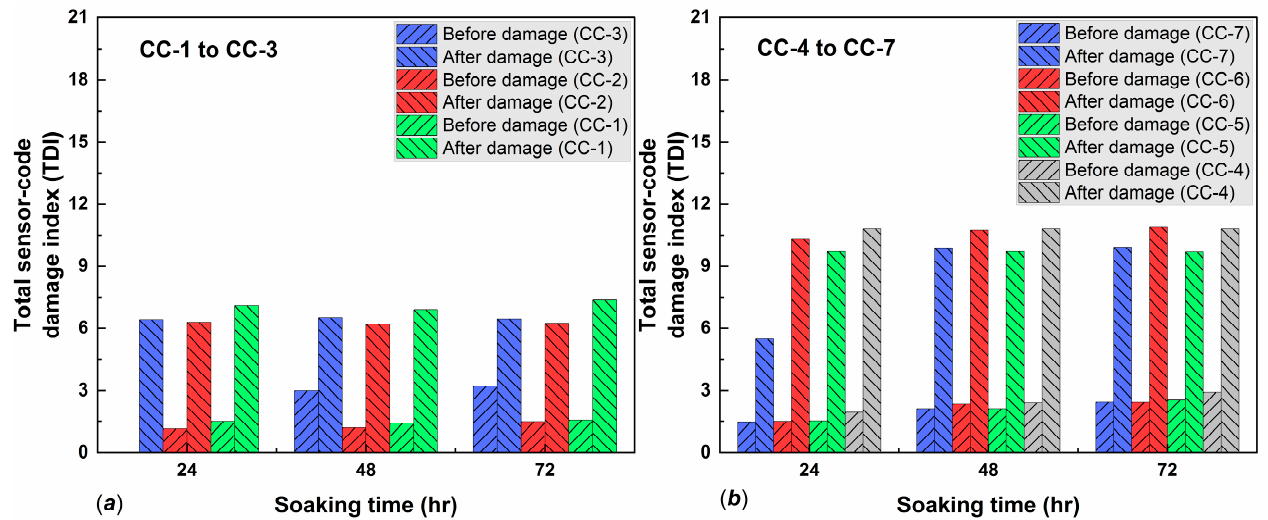
Figure 10. Seepage indicator based on TDI of ( a ) standard smart tags and ( b ) MPGE tags.